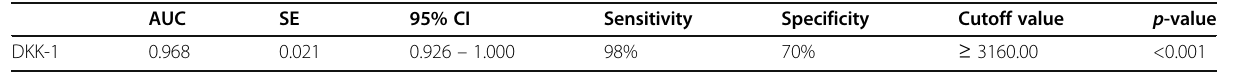
Table 3 The results of ROC curve analysis of DKK-1 in the studied SLE and normal